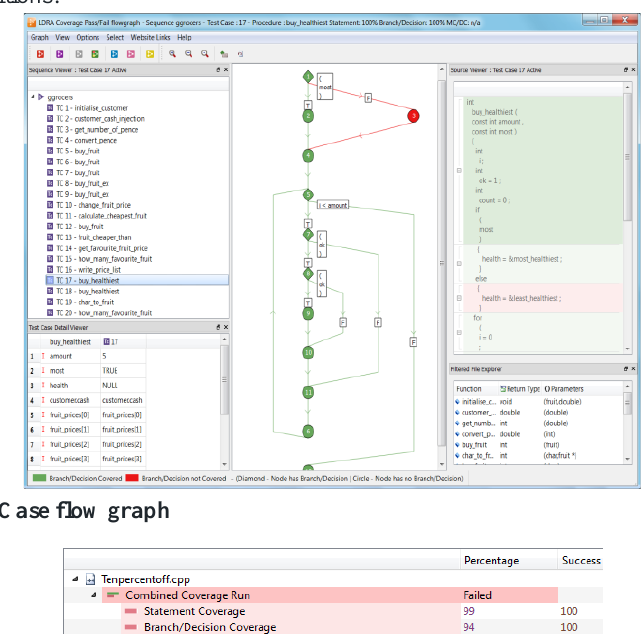
Fig. 4. Test Case flow graph